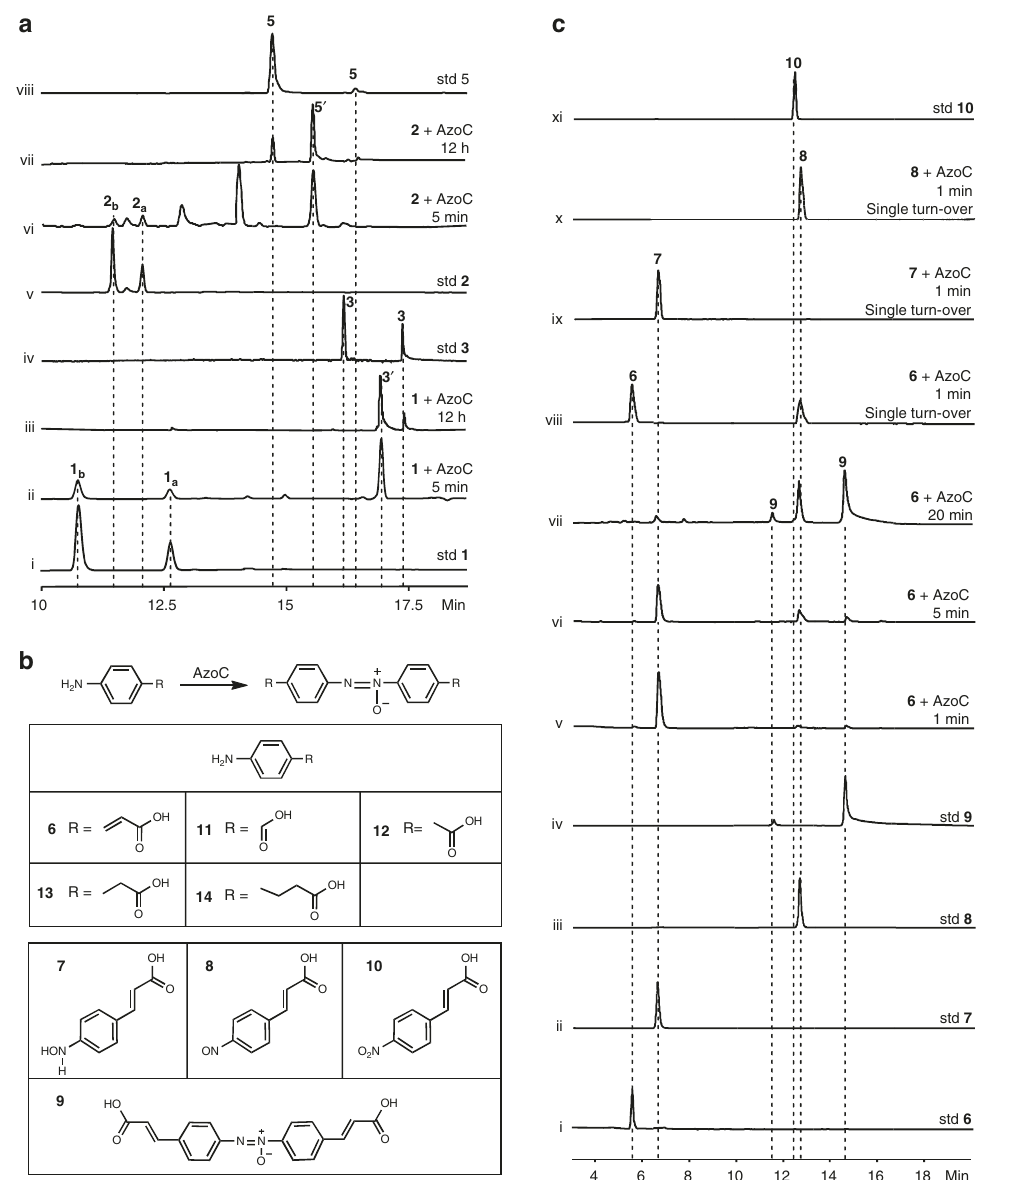
Fig. 2 Catalytic activity of AzoC for azoxy bond formation. a HPLC analysis of in vitro azoxymycins biosynthesis catalyzed by AzoC at 370 nm. Reactions were performed in 20 mM HEPES buffer (pH 7) with the addition of 1 mM NADH and 10 μ M PMS. (i) 100 μ M 1 , (ii) 100 μ M 1 with 10 μ M AzoC for 5 min, (iii) 100 μ M 1 with 10 μ M AzoC for 12 h, (iv) standard azoxymycin C ( 3 ), the RT 16.2 min peak is the trans N = N isomer, and the RT 17.4 min peak is the